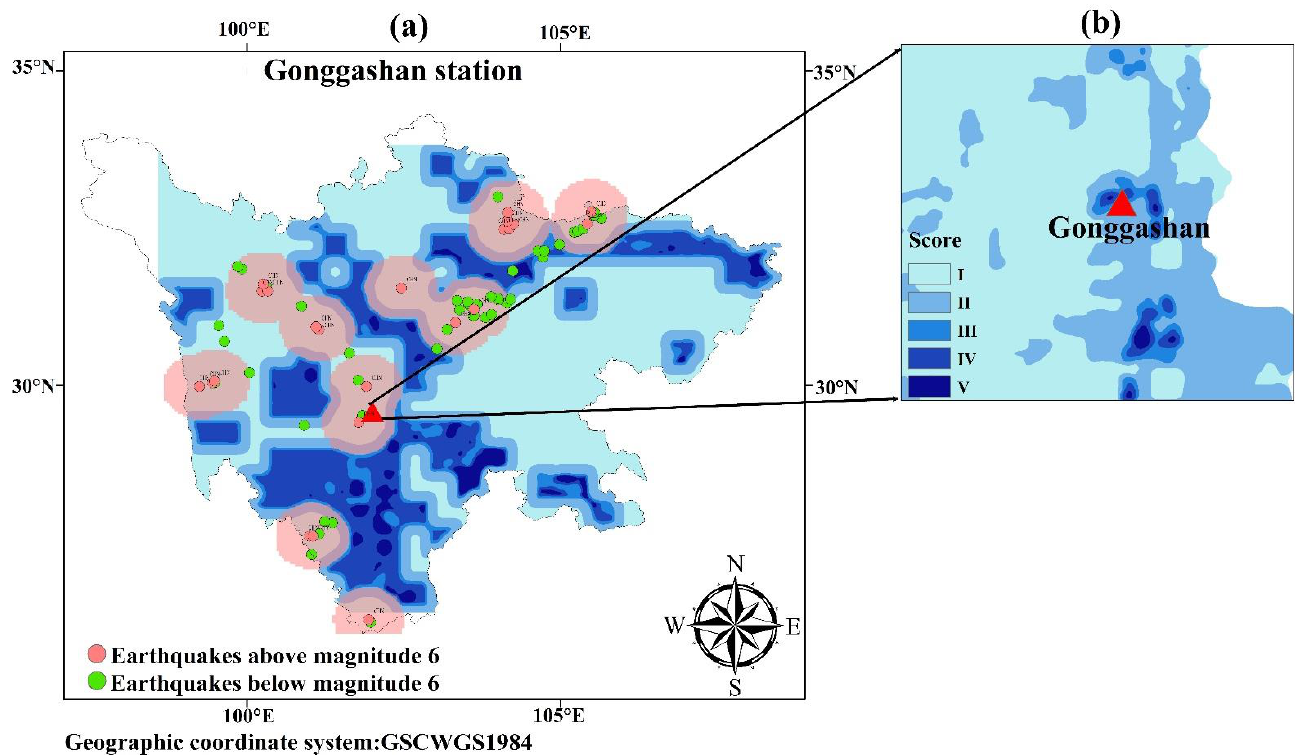
Figure 6. Gonggashan Station score density map: the result ( a ) refers to the score density map by DSS-LPV based on Random Forest; the green points represent the locations of earthquakes below magnitude 6 that have occurred in the past 50 years; The pink points represent the locations of earthquakes of magnitude 6 or higher that have occurred in the past 50 years; the pink circles are 50-kilmeter buffer zone; and ( b ) refers to the result without considering seismic factors.